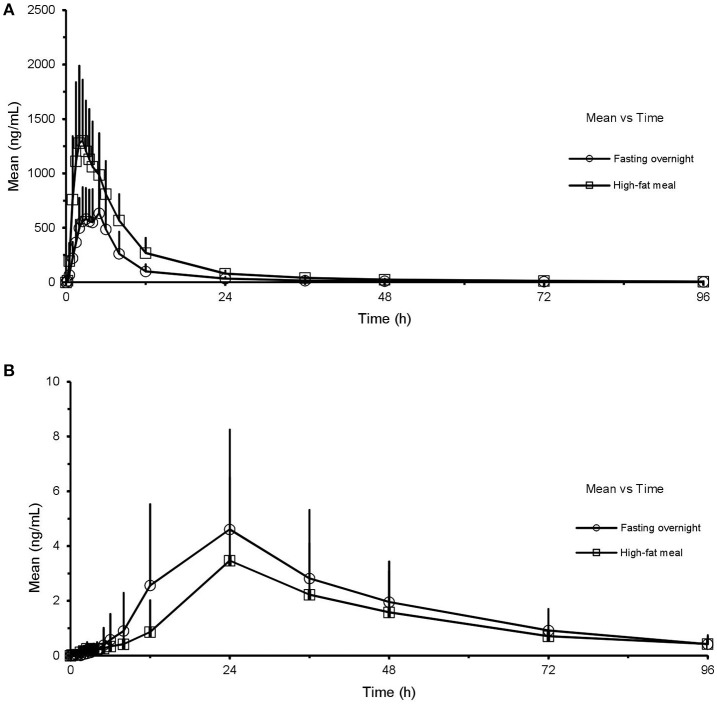
Mean (SD) plasma concentration-time profile of CK (A) and 20(S)-PPD (B) after oral administration of CK 200 mg in healthy volunteers (n = 24) under fasting overnight and after a high-fat meal, respectively. CK, compound K; PPD, protopanaxdiol; All values are presented as mean ± standard deviation.